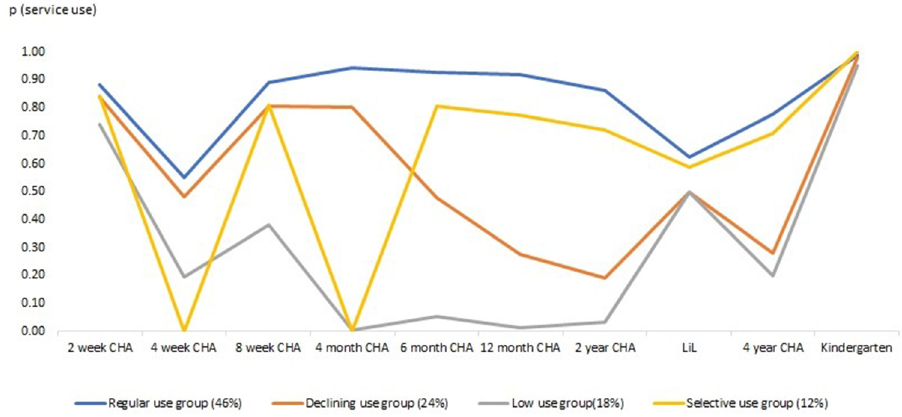
Figure 1: Probability of service event by latent